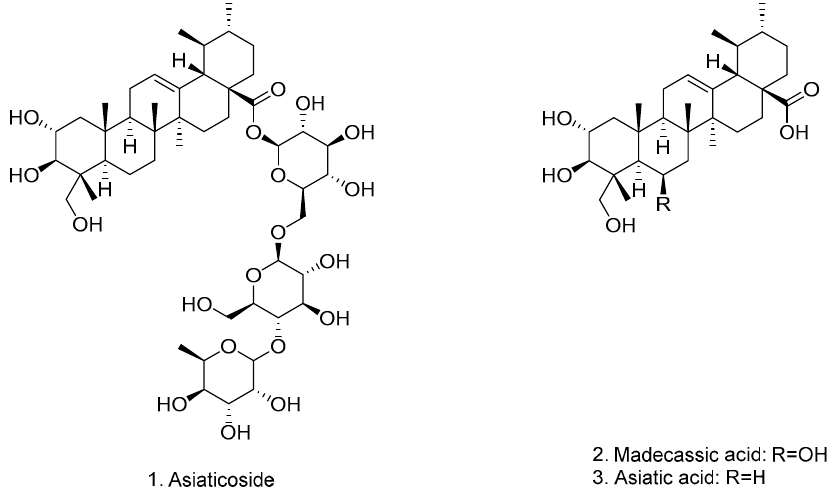
Figure 3. Chemical structures of compounds annotated in C. erecta by UHPLC-ESI-QTOF-MS anal- ysis.